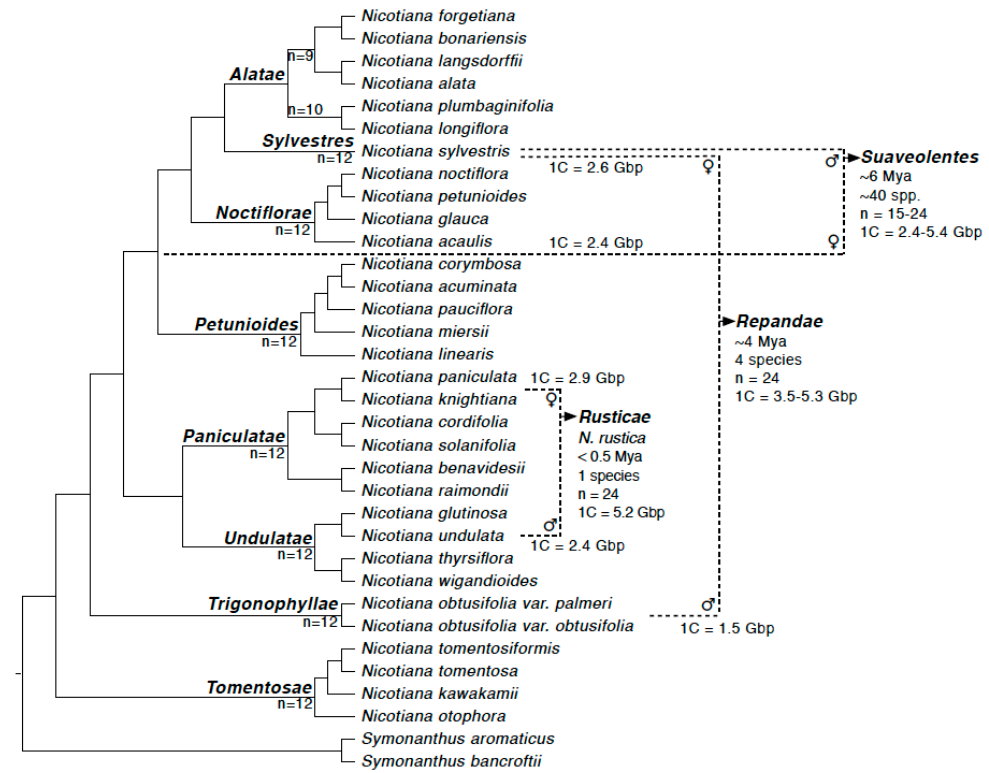
Figure 1. The evolutionary history of the three allotetraploid sections studied here ( Rusticae , Repandae and Suaveolentes ) including chromosome numbers, genome sizes and direction of hybridisation. Figure adapted from [19,21,22].